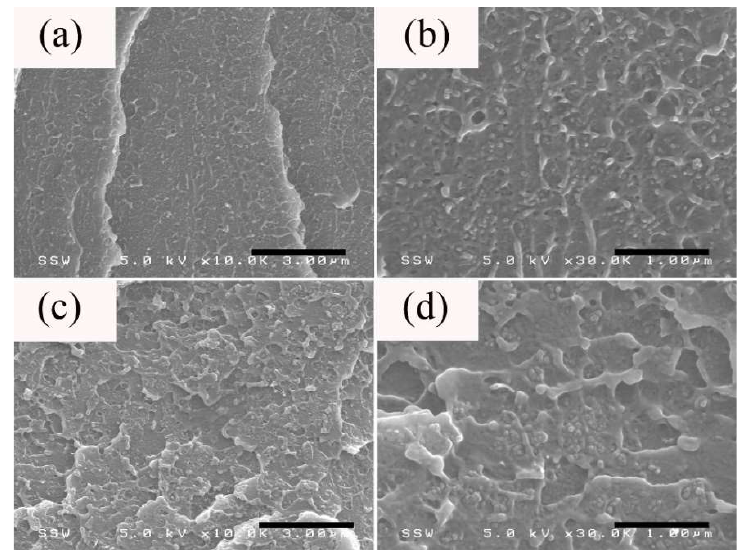
Figure 5. The morphology (TD) taken from the ( a , b ) core and ( c , d ) shear layers of the thick section of PS/CB 5 wt % microparts.